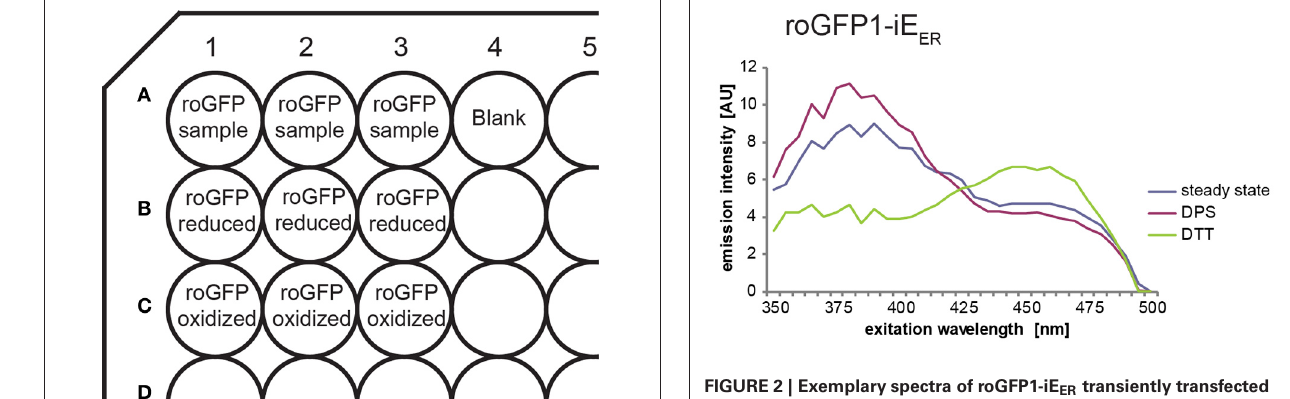
FIGURE 2 | Exemplary spectra of roGFP1-iE ER transiently transfected into HeLa cells. The lines in the graph represent the averaged and blank corrected fluorescence intensities from cells at steady state (blue), upon oxidation with DPS (red), or reduction with DTT (green). The redox-dependentratiometric behavior of the two peaks of roGFP1-iE ER at 390 and 465nm is